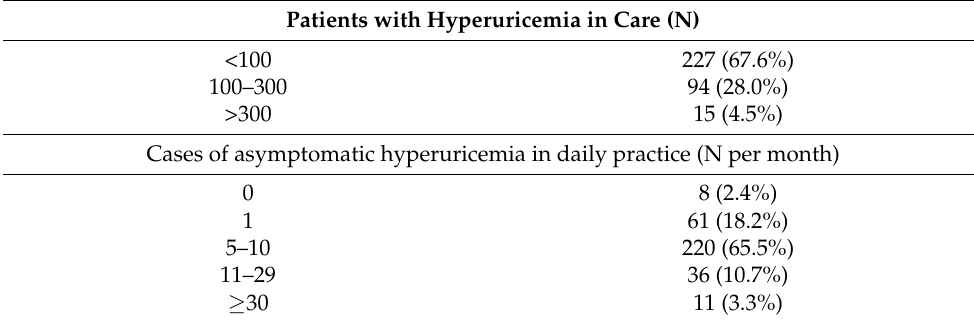
Table 2. Gout and asymptomatic hyperuricemia management